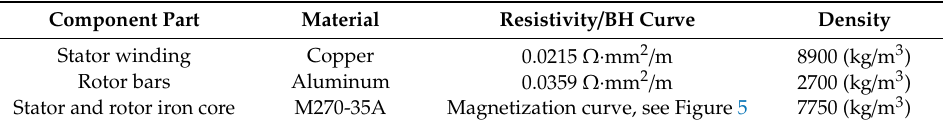
Table 2. Active materials used for IM and their characteristics.